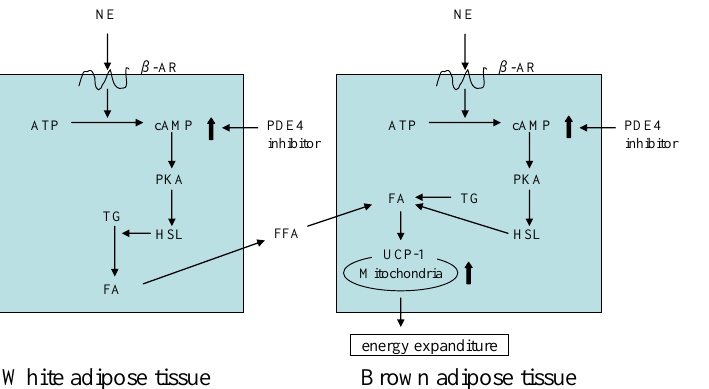
Figure 4. Mechanism of energy expenditure in adipose tissues induced by norepinephrine (NE). â- AR: â-Adrenergic receptor; ATP: Adenosine triphosphate; PKA; Protein kinase A; HSL;